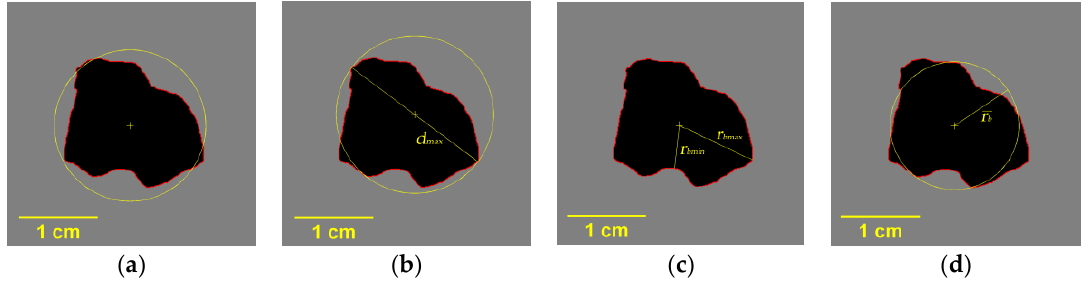
Figure 6. Diagrams of four circularity determination methods: ( a ) Form Factor; ( b ) Roundness Factor; ( c ) Radius Ratio; and, ( d ) Mean Roundness.